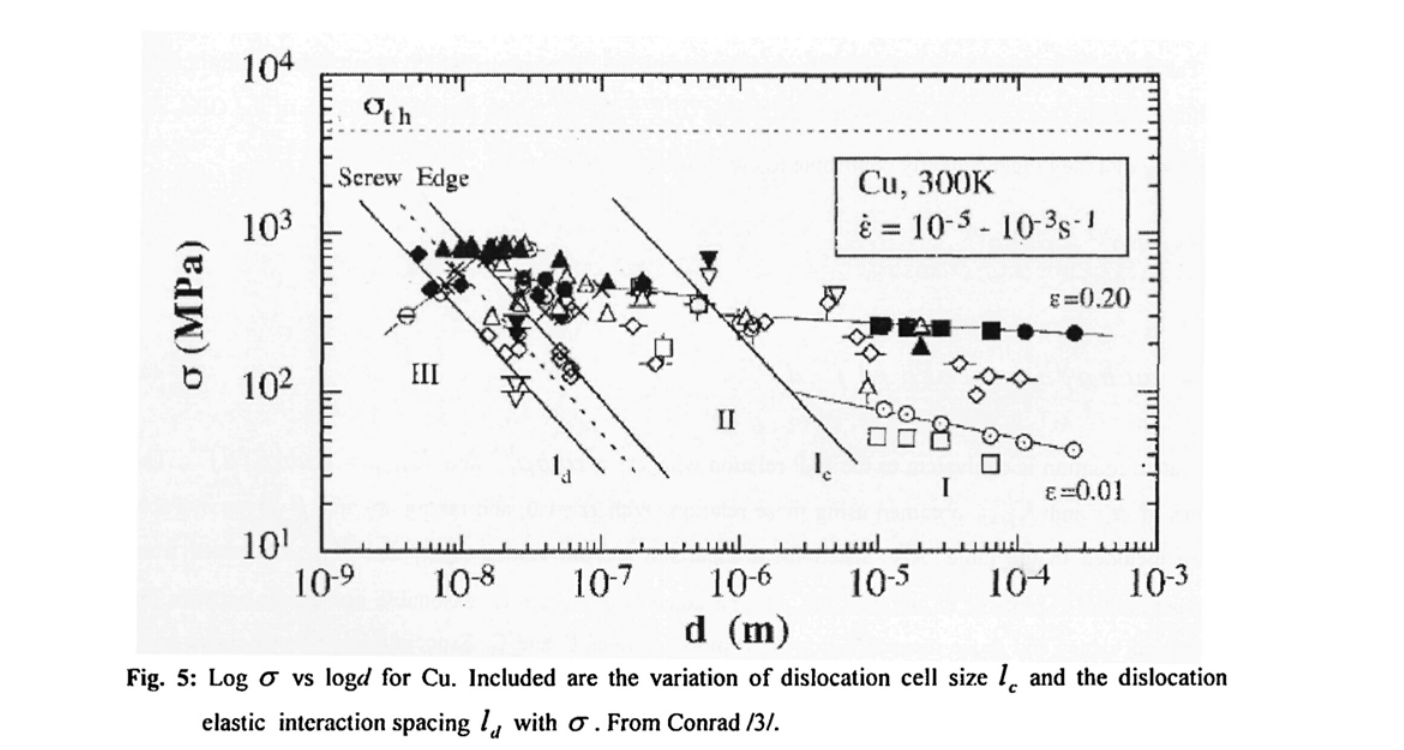
with σ. From Conrad d